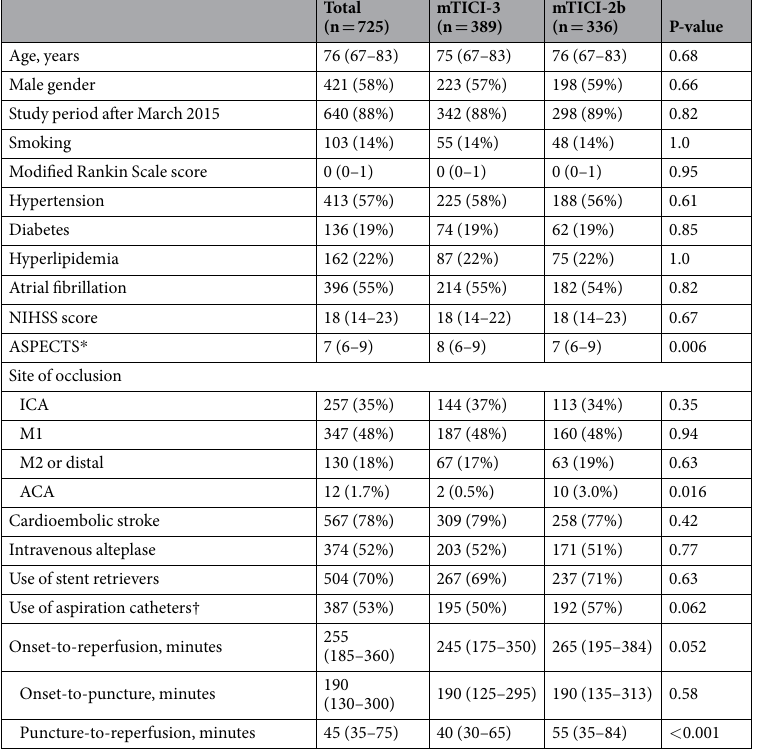
Table 1. Patient characteristics. Data are presented as n (%) or median (interquartile range). ACA, anterior cerebral artery; ASPECTS, Alberta Stroke Program Early Computerized Tomography Score; ICA, internal carotid artery; mTICI, modified treatment in cerebral infarction; NIHSS, National Institutes of Health Stroke Scale; M1, the horizontal segment of the middle cerebral artery; and M2, the insular segment of the middle cerebral artery. * If both CT and MRI were performed before treatment, the lower one was used. † The utilization of an aspiration catheter as a distal access device was also counted.